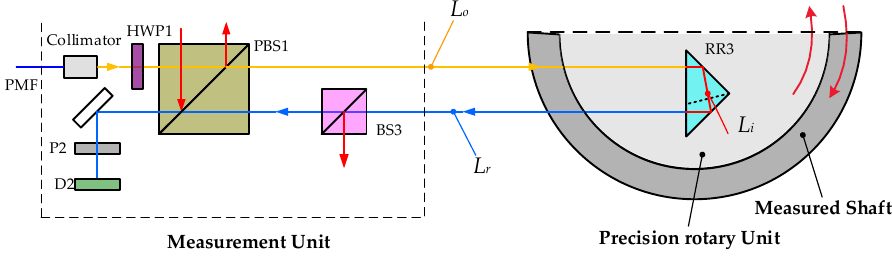
Figure 4. Optical path of the interference.